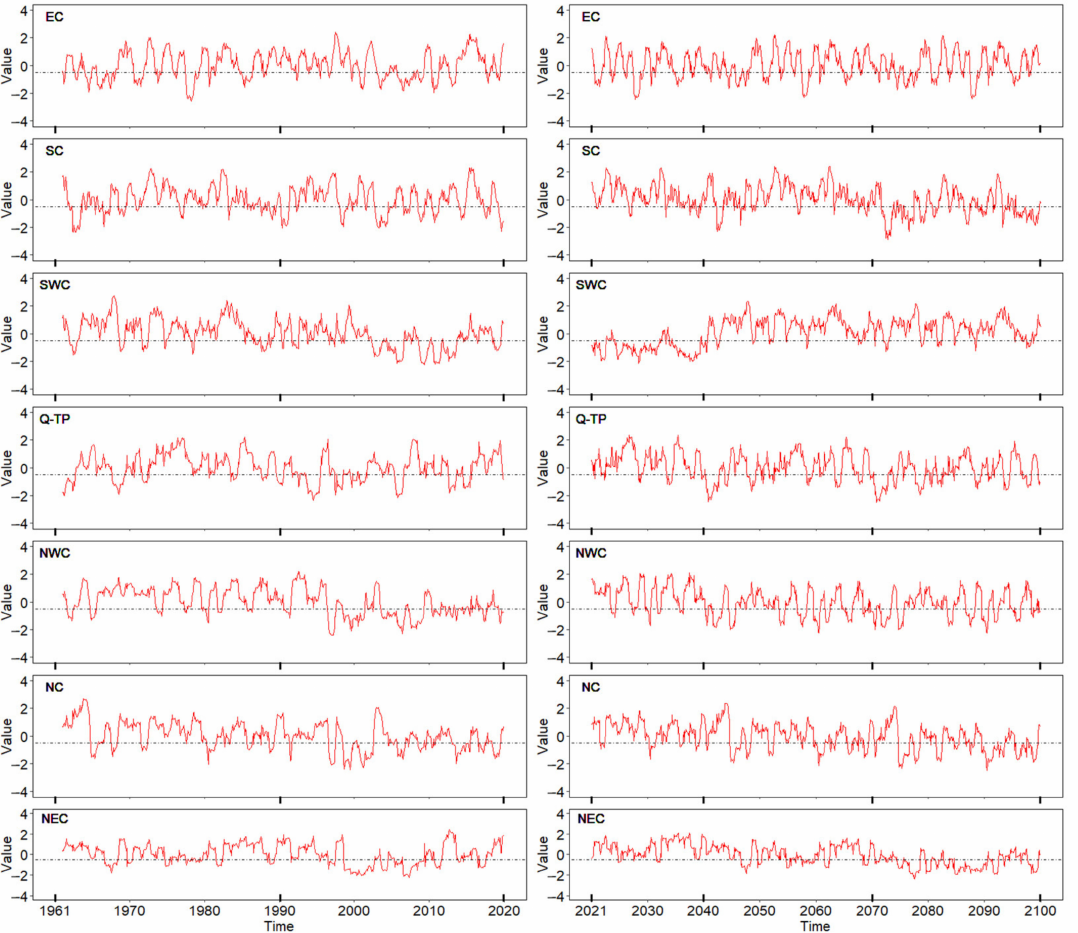
Figure 3. SPEI for different sub-regions during the historical and future periods. The dotted line is the threshold level of − 0.5. Table 4. The results of the Mann–Kendall test and Sen’s slope for SPEI in each sub-region during